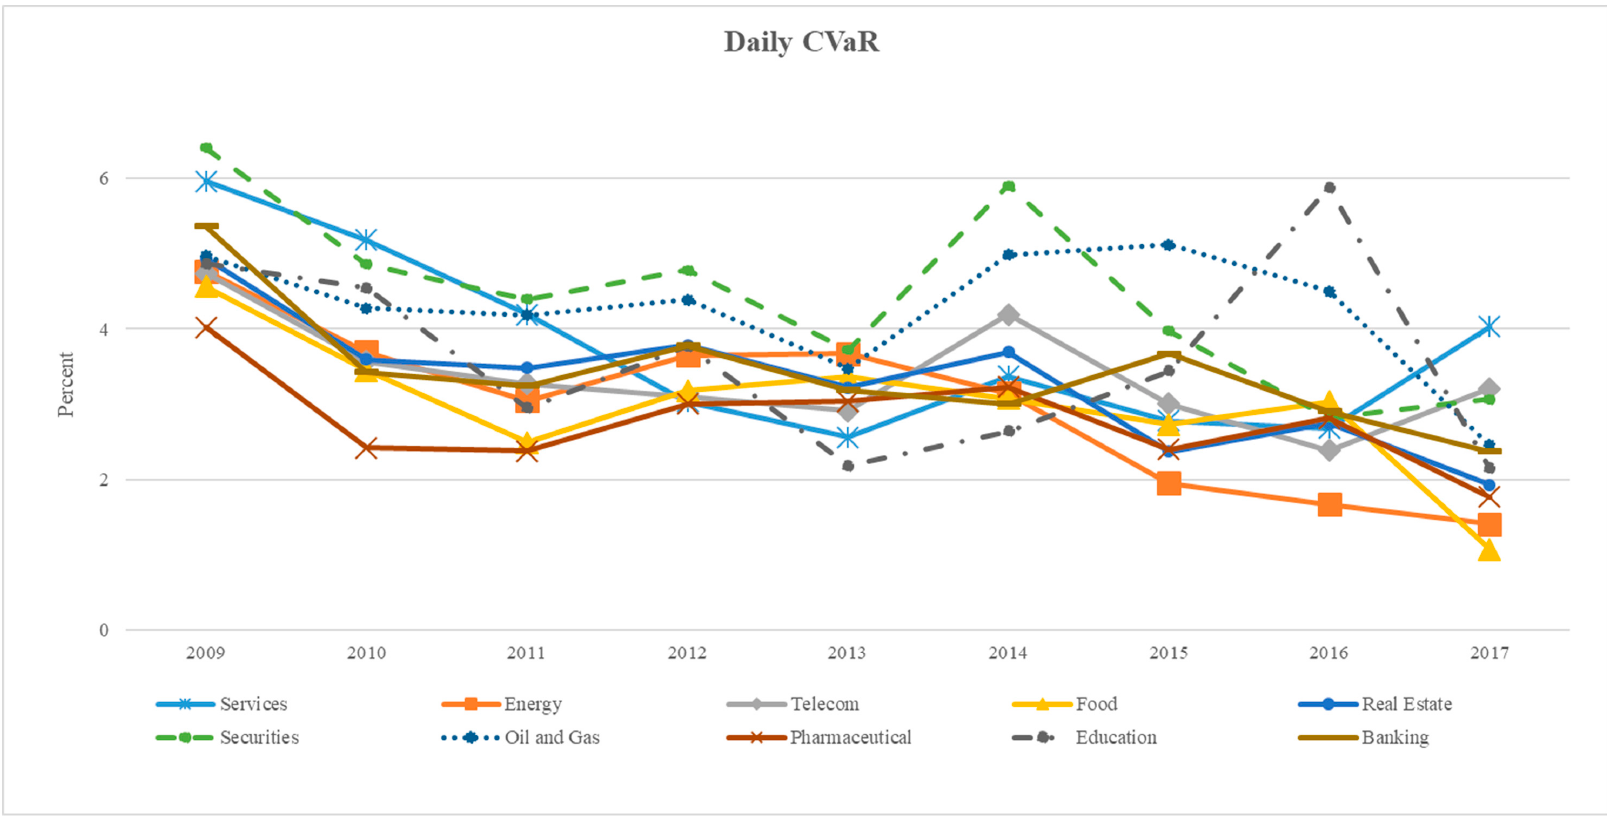
Figure 2. Daily CVaR at 95% confidence for ten industries.